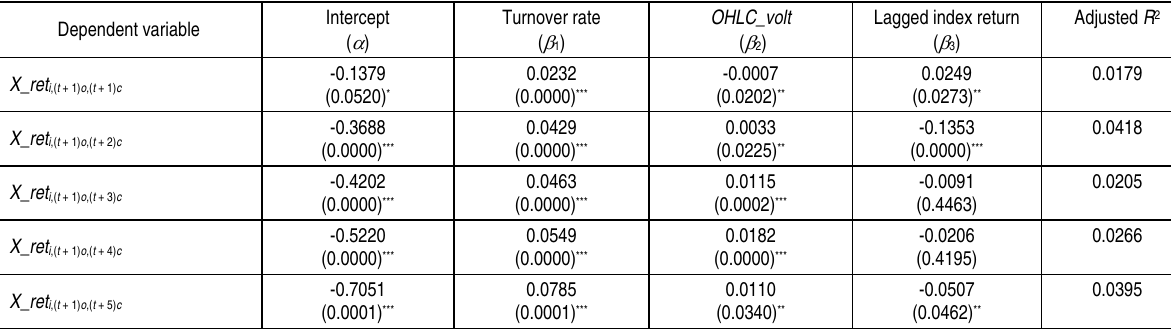
Table 2. Inverse ETF trading and future index